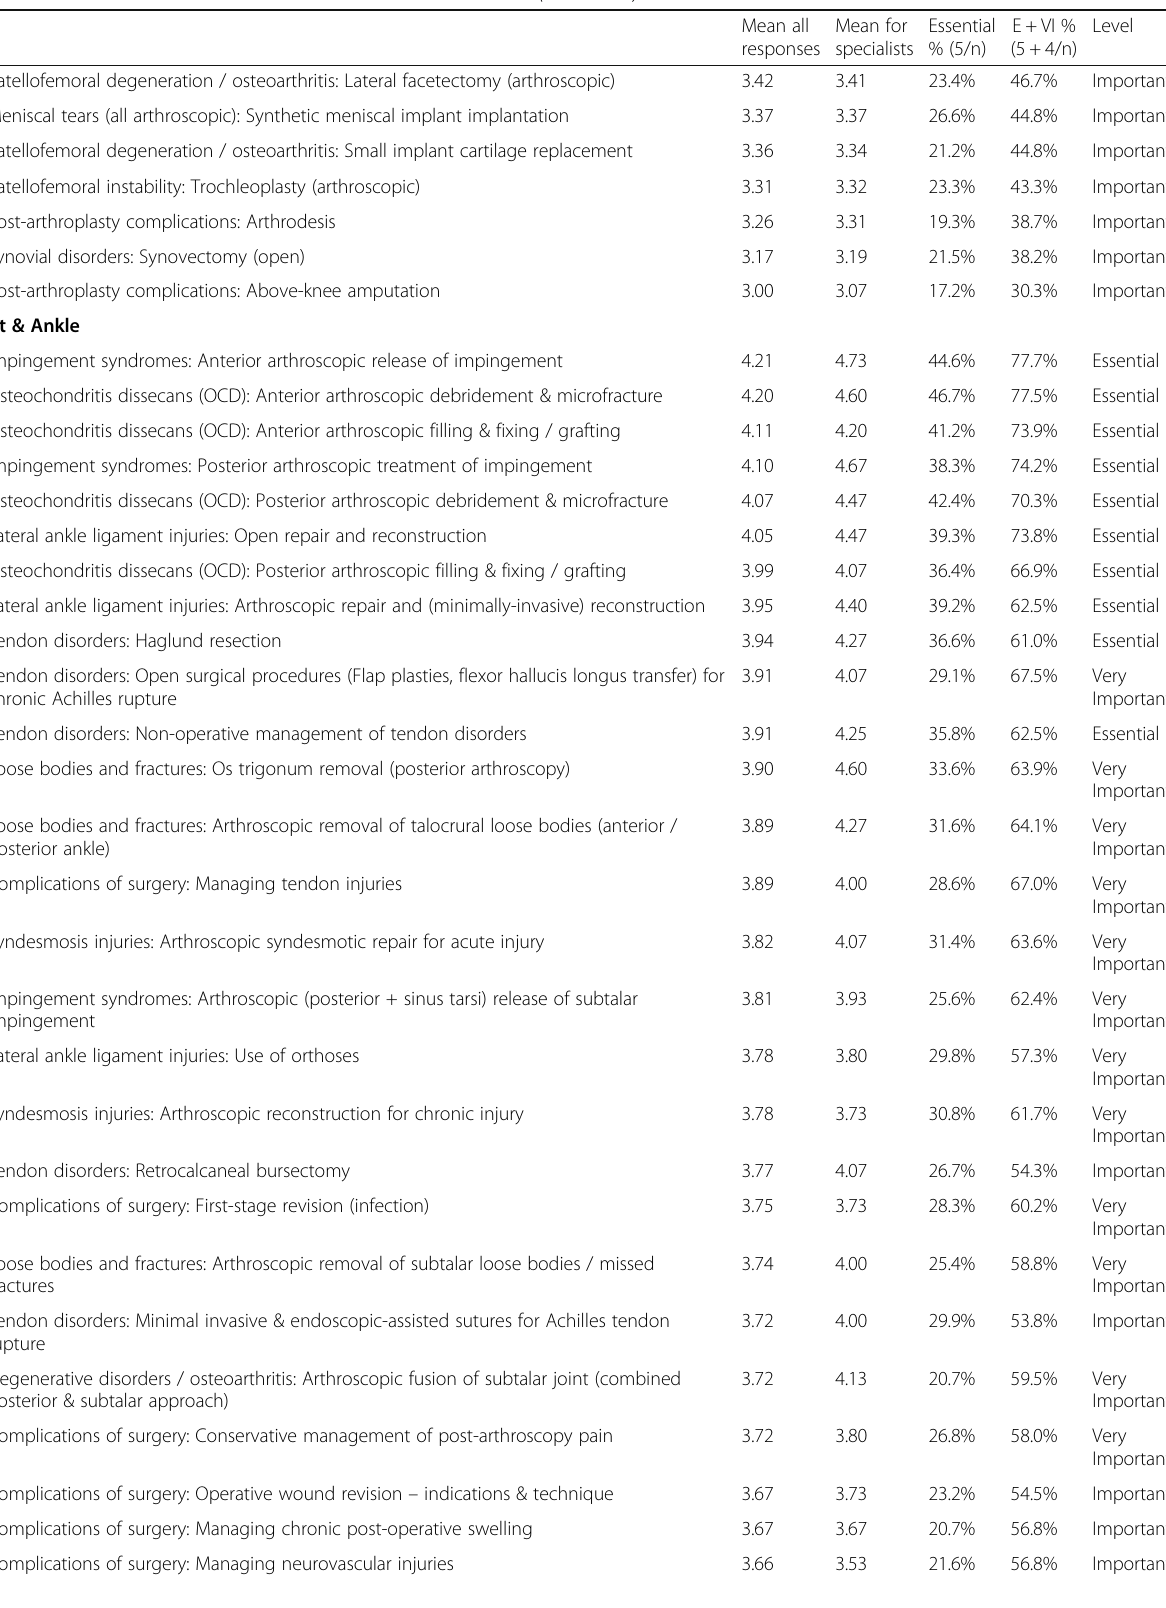
Table 2 For insertion in the results section as indicated above